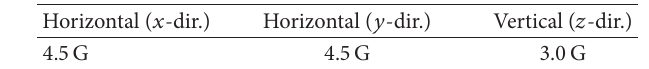
Table 3: Results of structural analysis based on static analysis for Grade D of the KEPIC